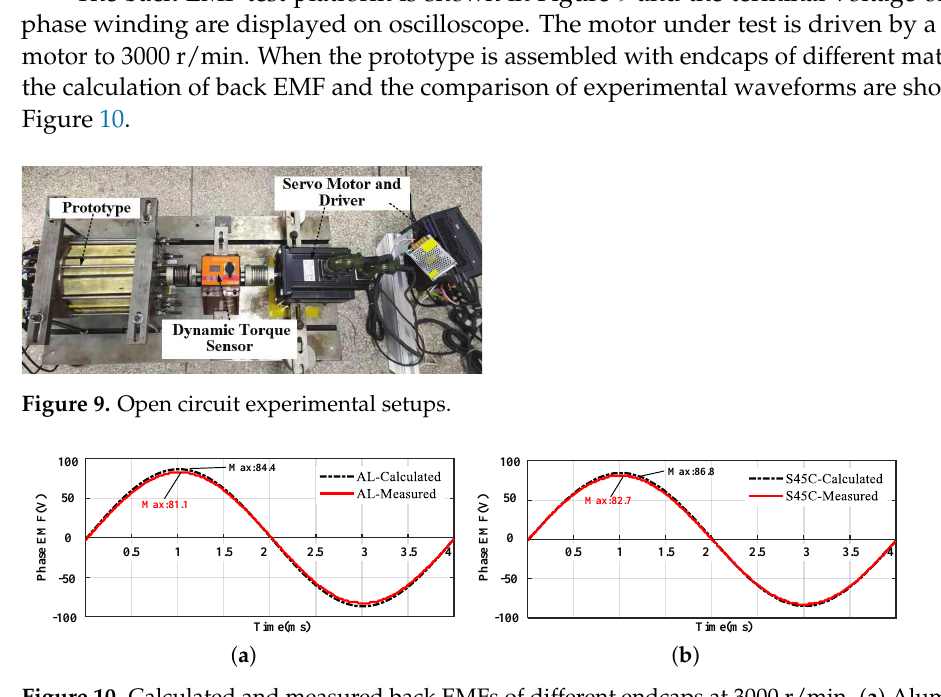
Figure 10. Calculated and measured back EMFs of different endcaps at 3000 r/min. ( a ) Aluminum. ( b )